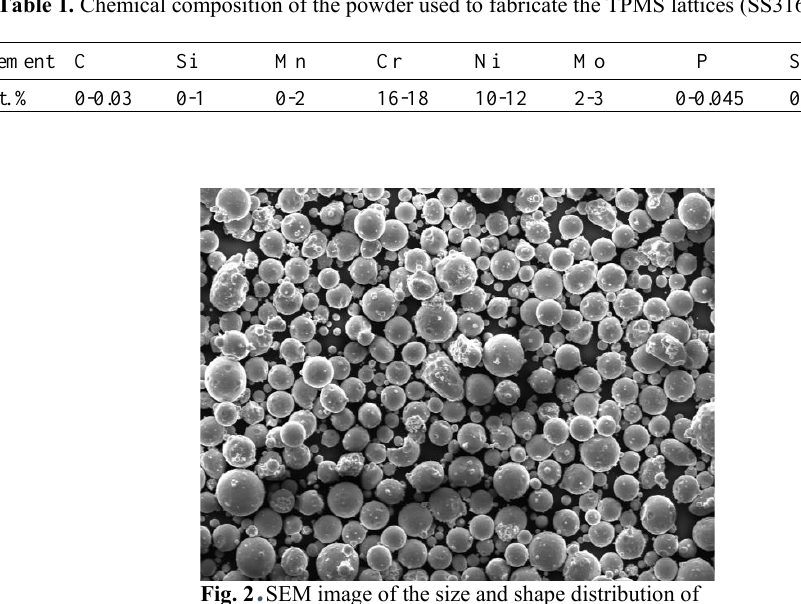
Fig. 2 . SEM image of the size and shape distribution of stainless steel